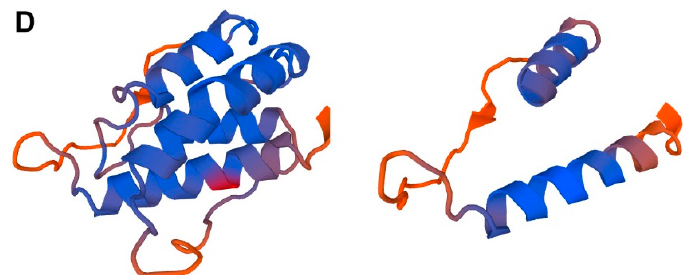
Figure 1. TSLP transcript variants and protein isoforms. ( A ) Graphics showing the TSLP gene (green), the long form, and short form transcripts (blue), and the protein products (red). Long (NM_033035.4, NP_149024.1) and short (NM_138551.3, NP_612561.2) transcript and protein variants, respectively, are indicated (NCBI). ( B ) Amino acid sequence of human TSLP isoforms. The putative signal sequences of the TSLP isoforms are marked in blue, and the mature protein in black. N-linked glycosylation sites are marked green, and methionine start codons are marked red. Bold black characters indicate the position of MKK34. ( C ) JNet secondary structure prediction of lfTSLP based on the amino acid sequence. Helices are marked as red tubes, and sheets are marked as green arrows. JNETCONF: The confidence estimate for the prediction, high values indicate high confidence. Modified from the web-based application Jpred (The Barton Group, School of Life Sciences, University of Dundee, UK). ( D ) Three-dimensional structure (Swiss-model, [9]) of lfTSLP ( left ) and sfTSLP ( right